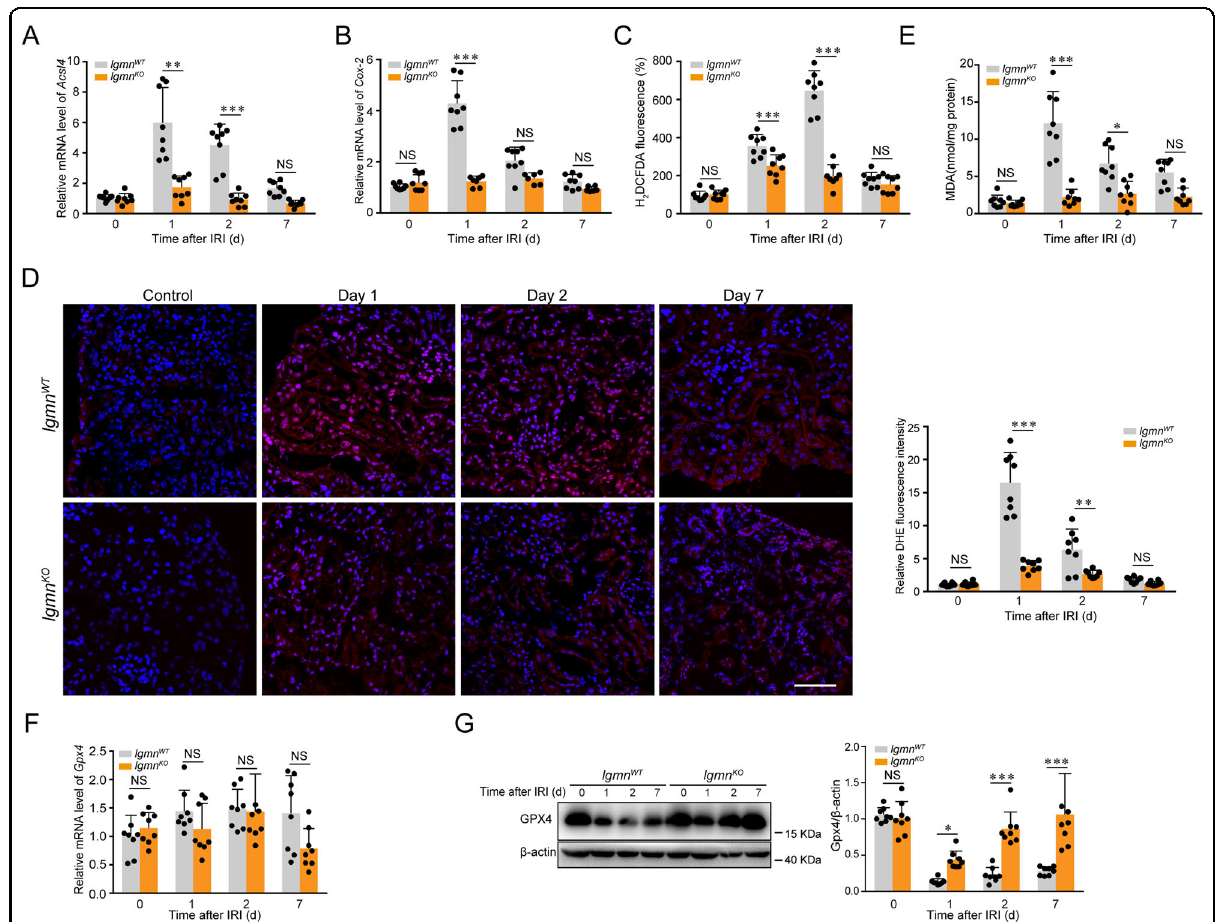
Fig. 3 Legumain de fi ciency inhibits IRI-induced tubular ferroptosis. Collection of kidney samples was performed as described in Fig. 1 (n = 8). A & B Quanti fi cation of kidney Acsl4 and Cox-2 mRNA levels by qPCR. C Level of intracellular ROS in kidneys measured by the fl uorescent probe carboxy-H 2 DCFDA. D Representative images of the fl uorescence assay (left panel) and quanti fi cation (right panel) of ROS in kidneys using the fl uorescent probe DHE (red), DAPI (blue) was used to stain the nuclei. Scale bar, 50 μ m. E Levels of lipid peroxidation in kidneys were measured by MDA assay. F Quanti fi cation of kidney GPX4 mRNA levels by qPCR. G Protein levels of GPX4 in kidney samples assessed by western blotting. Statistical results are shown in the right panel. All data are expressed as the mean ± SD. * P < 0.05, ** P < 0.01, *** P < 0.001; two-way